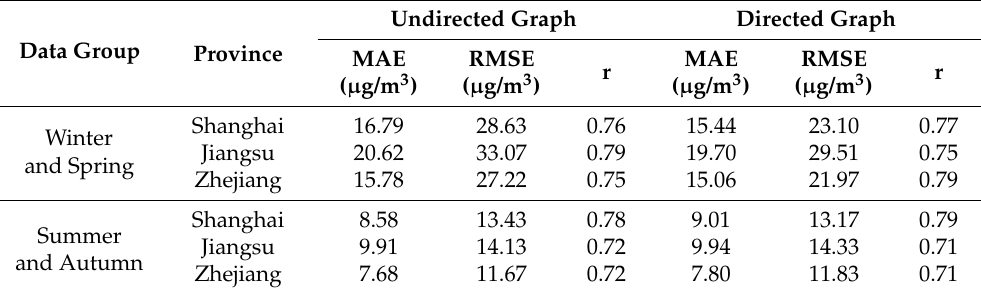
Figure 5. Regional prediction of PM 2.5 and ozone based on the DCRNN model at different time steps. ( a ) PM 2.5 , MAE; ( b ) PM 2.5 , RMSE; ( c ) PM 2.5 , r; ( d ) ozone, MAE; ( e ) ozone, RMSE; ( f ) ozone, r. Table 5. The performance of the DCRNN model in forecasting PM 2.5 concentrations in different geographical